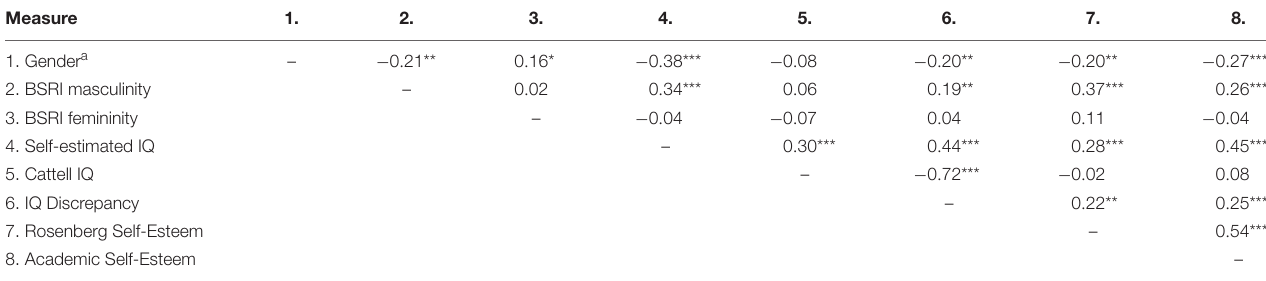
TABLE 2 | Bivariate correlations between gender and sex-role measures, self-estimated intelligence, measured intelligence, general and academic self-esteem ( N = 228).